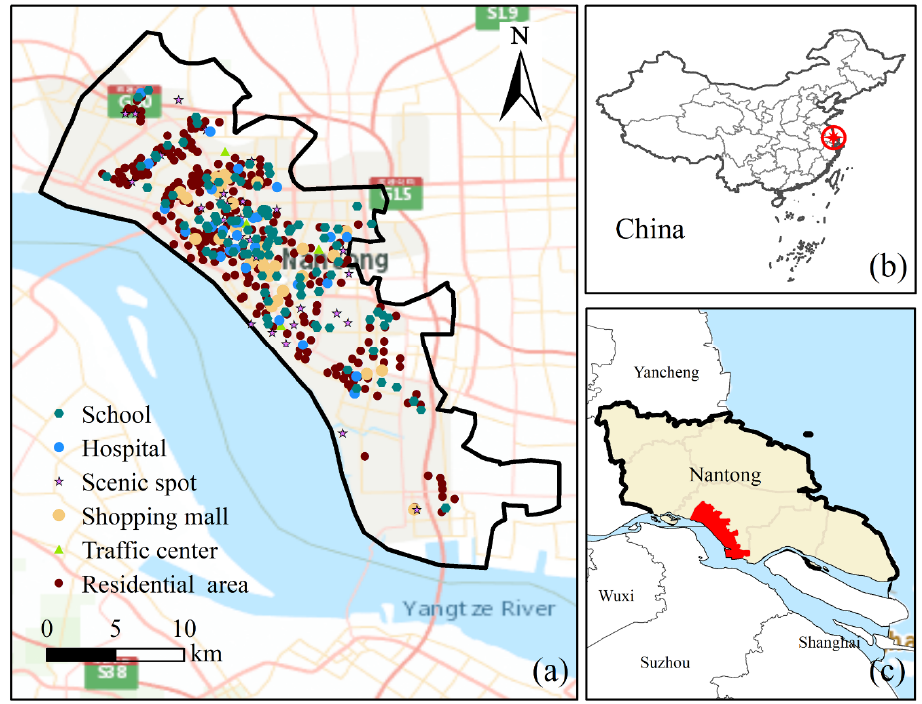
Figure 1. Study area. ( a ) Chongchuan District and marked points with attributes of UFAs, ( b ) map of China, ( c ) Nantong City.